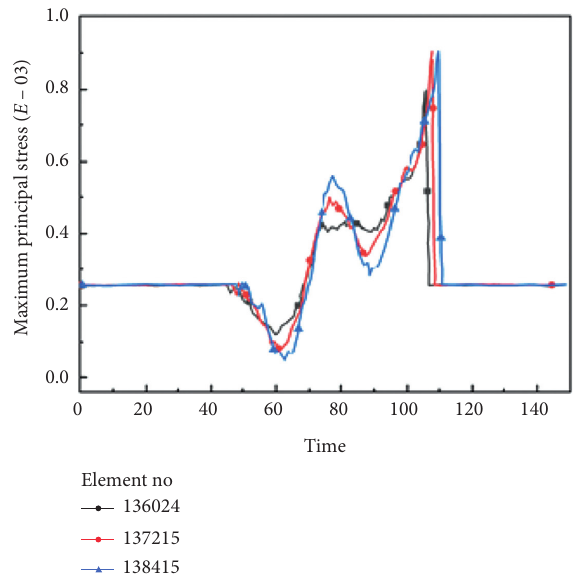
Figure 13: Curve of equivalent stress-time on selected elements.